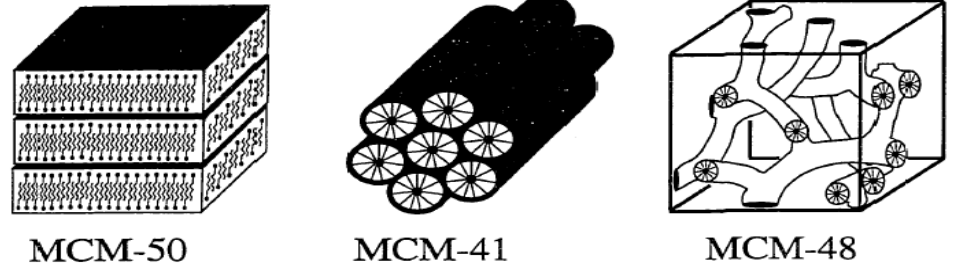
Figure 5. Schematic diagram of the M41S materials, MCM-50 (layered), MCM-41 (hexagonal) and MCM-48